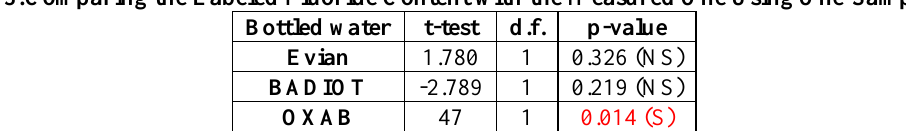
Table 3:Comparing the Labeled Fluoride Content with the Measured One Using One-Sample